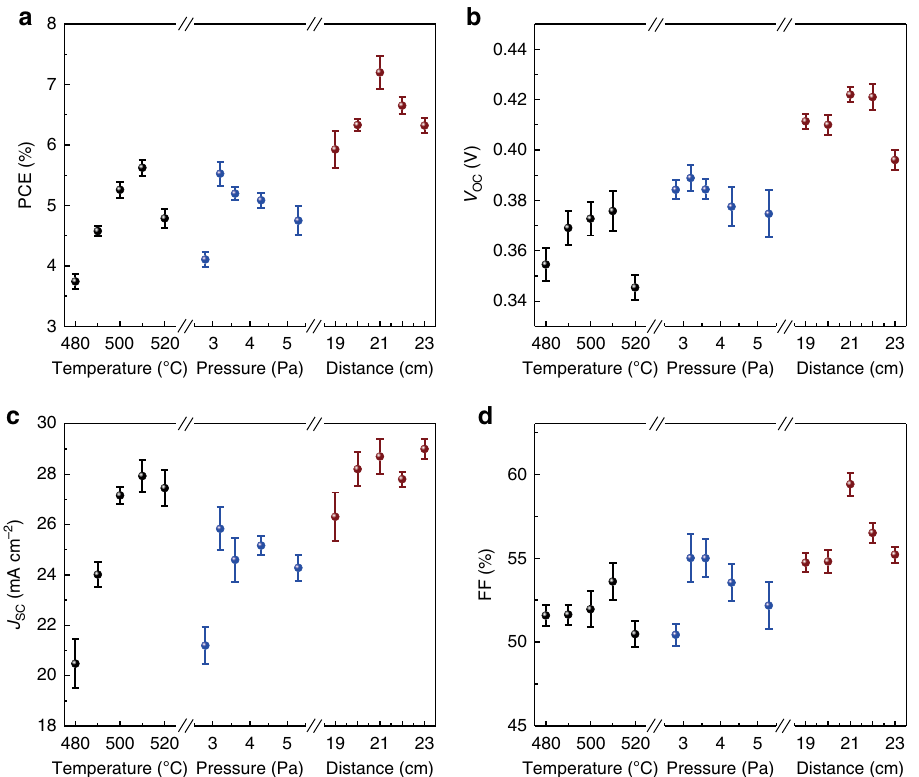
Fig. 2 Deposition condition-dependent photovoltaic characteristics. a Power conversion ef fi ciency (PCE), b open-circuit voltage ( V OC ), c short-circuit current density ( J SC ) and d fi ll factor (FF) of the CdS/Sb 2 Se 3 solar cells fabricated by VTD process. A total of 135 devices are included for the statistics analysis. Solid sphere symbols and error bars indicate average values and standard deviations,